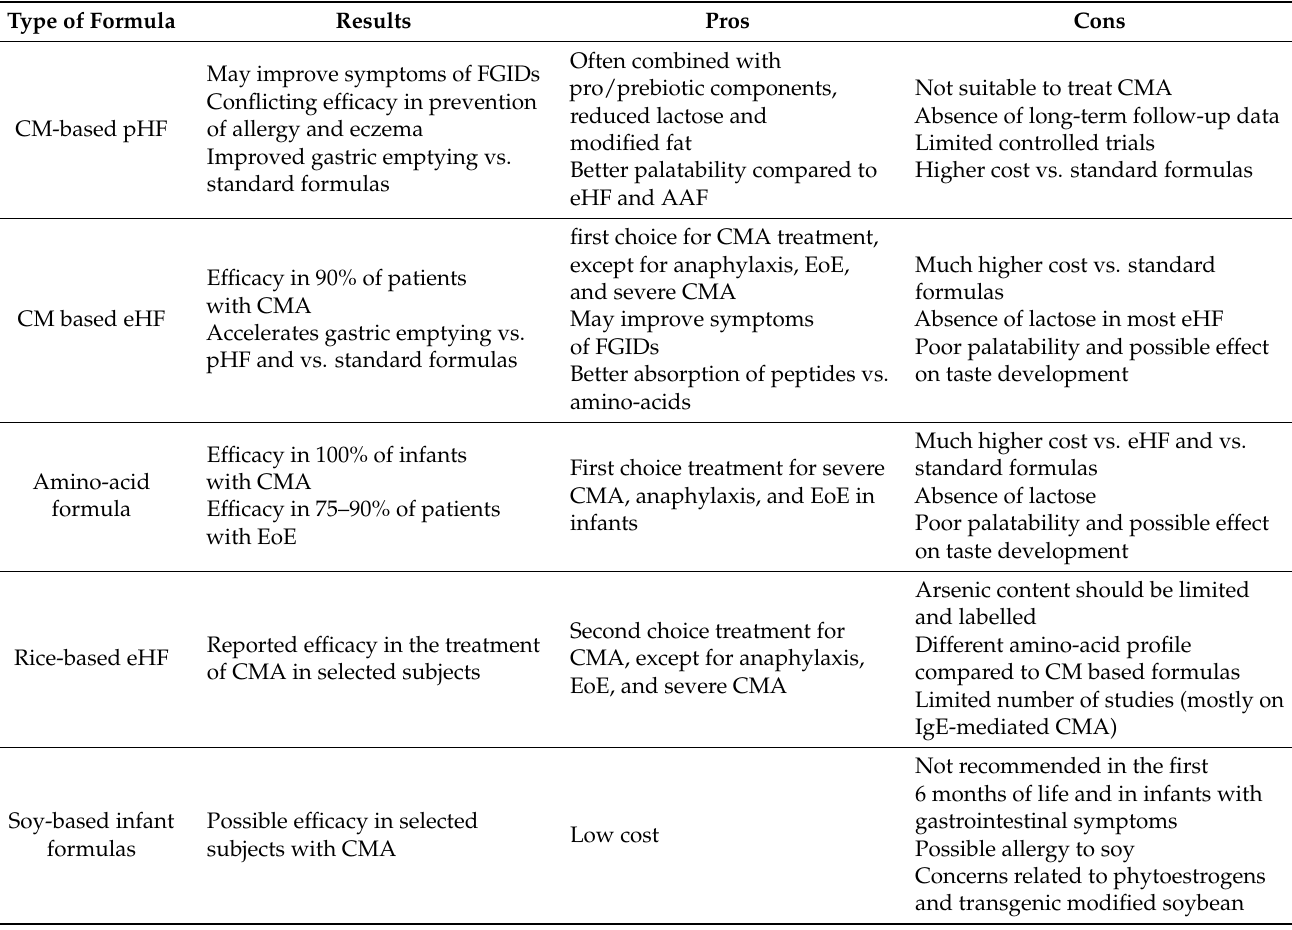
Table 4. Hydrolysed formulas: pros and